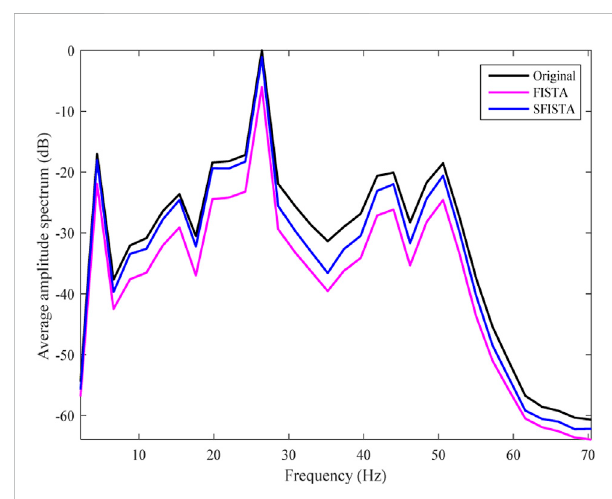
FIGURE 11 Average amplitude spectrum from original data, interpolated with FISTA and SFISTA